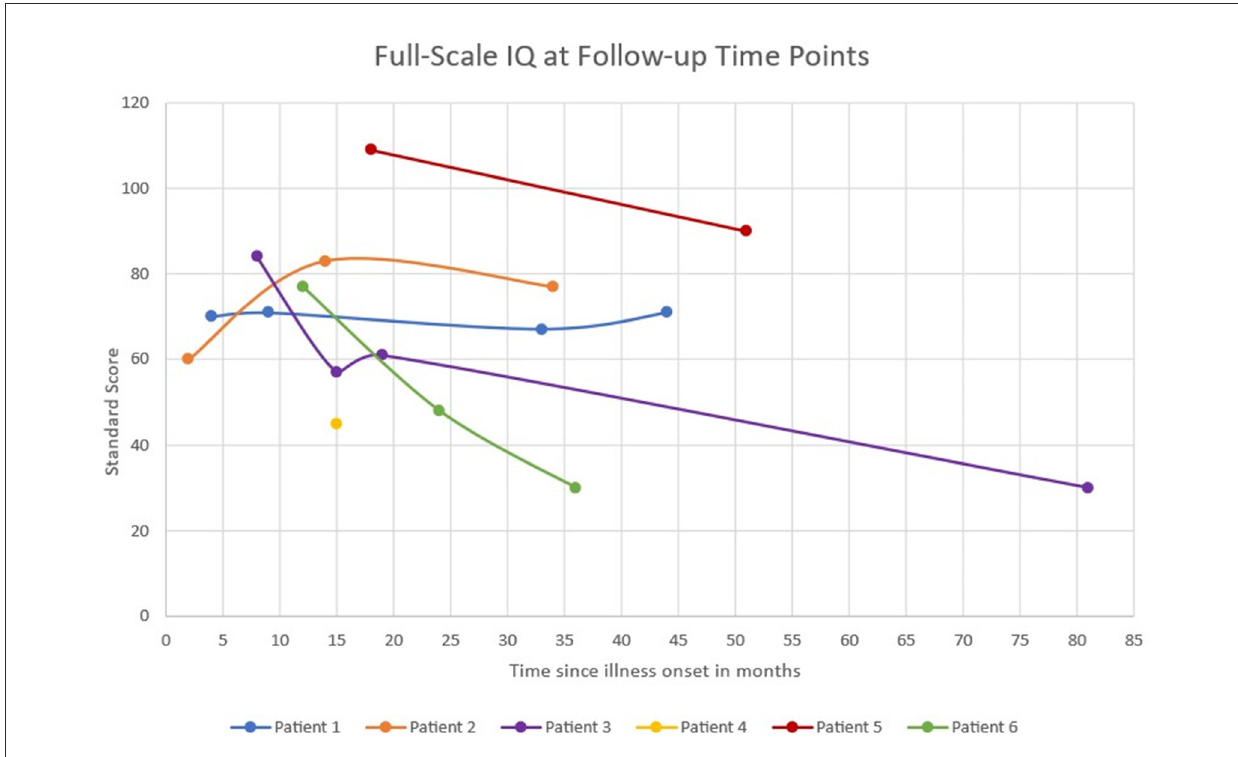
FIGURE1 Full-scale IQ scores at serial follow-up time points. Full-scale IQ score categories: Average 90–109, Low average 80–89, Borderline 70–79, Extremely low < 69.